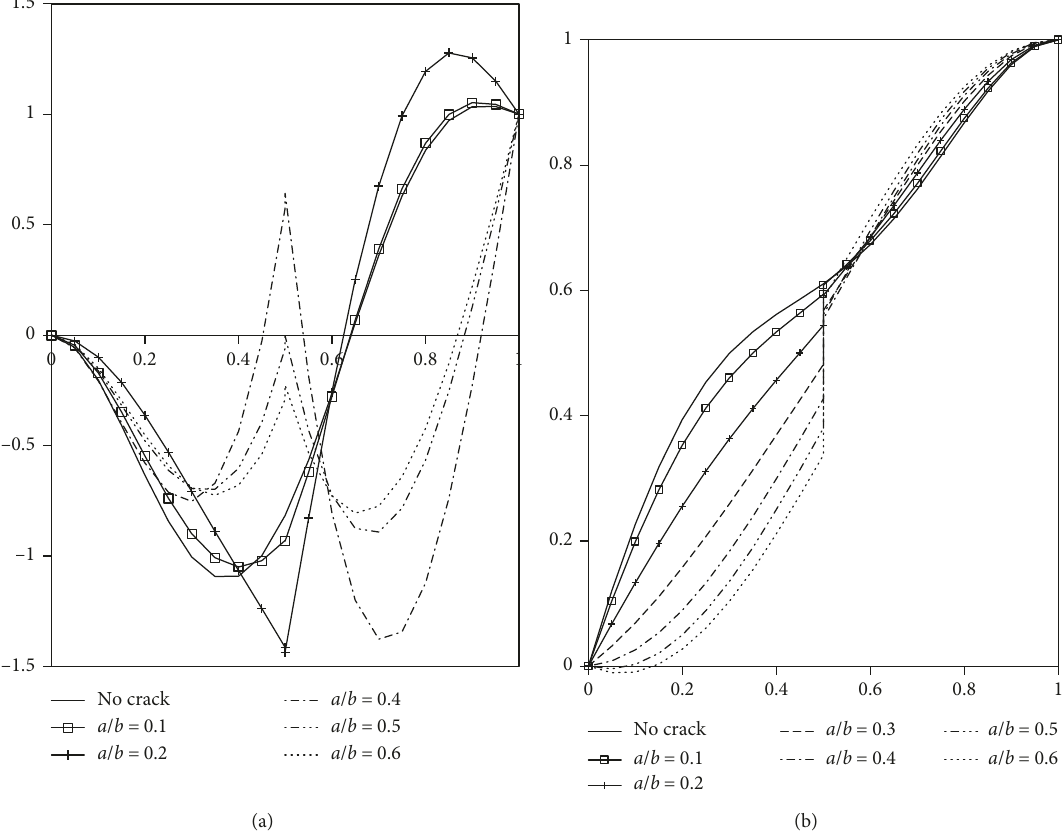
Figure 7: Third mode: (a) bending and (b) torsion of a composite beam with a crack located at 50% span and unidirectional ply angle of 70 ° .